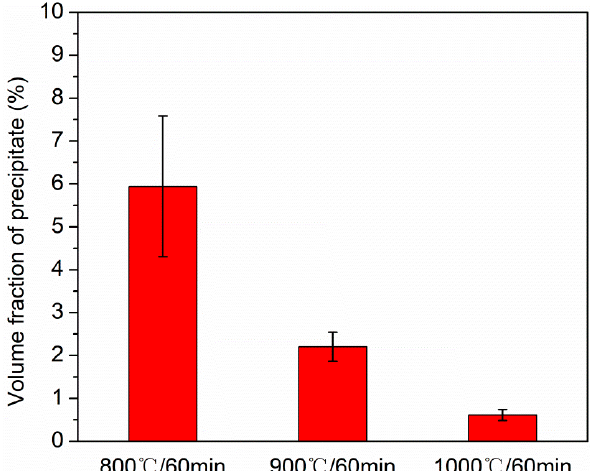
Figure 8. Volume fraction of precipitate in different HEA states.